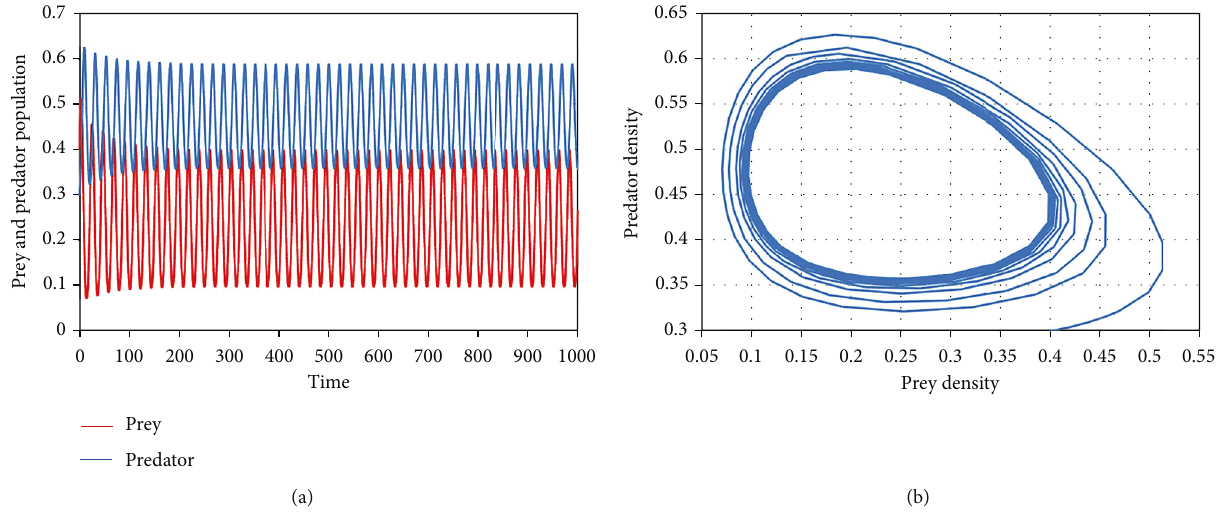
Figure 12: (a) The density of prey population for the parameter values as in Table 2 except c and (b) the density of predator population for the parameter values as in Table 2 except c 1 = 0 : 35, α = 0 : 5, and β = 0 : 7,2, 5, 7 and c 2 = 0 : 1 . 0.7